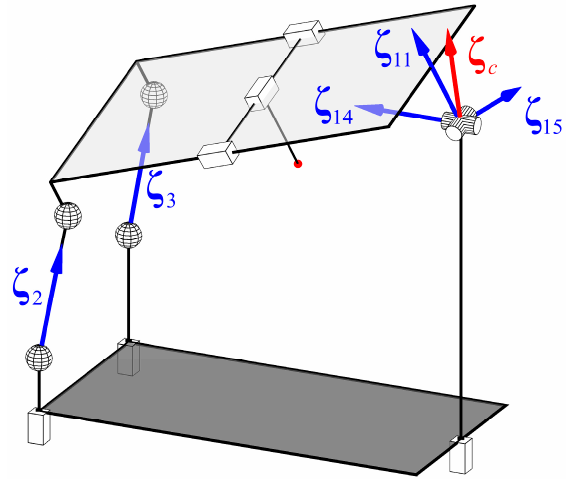
Figure 4. Wrenches of the manipulator.